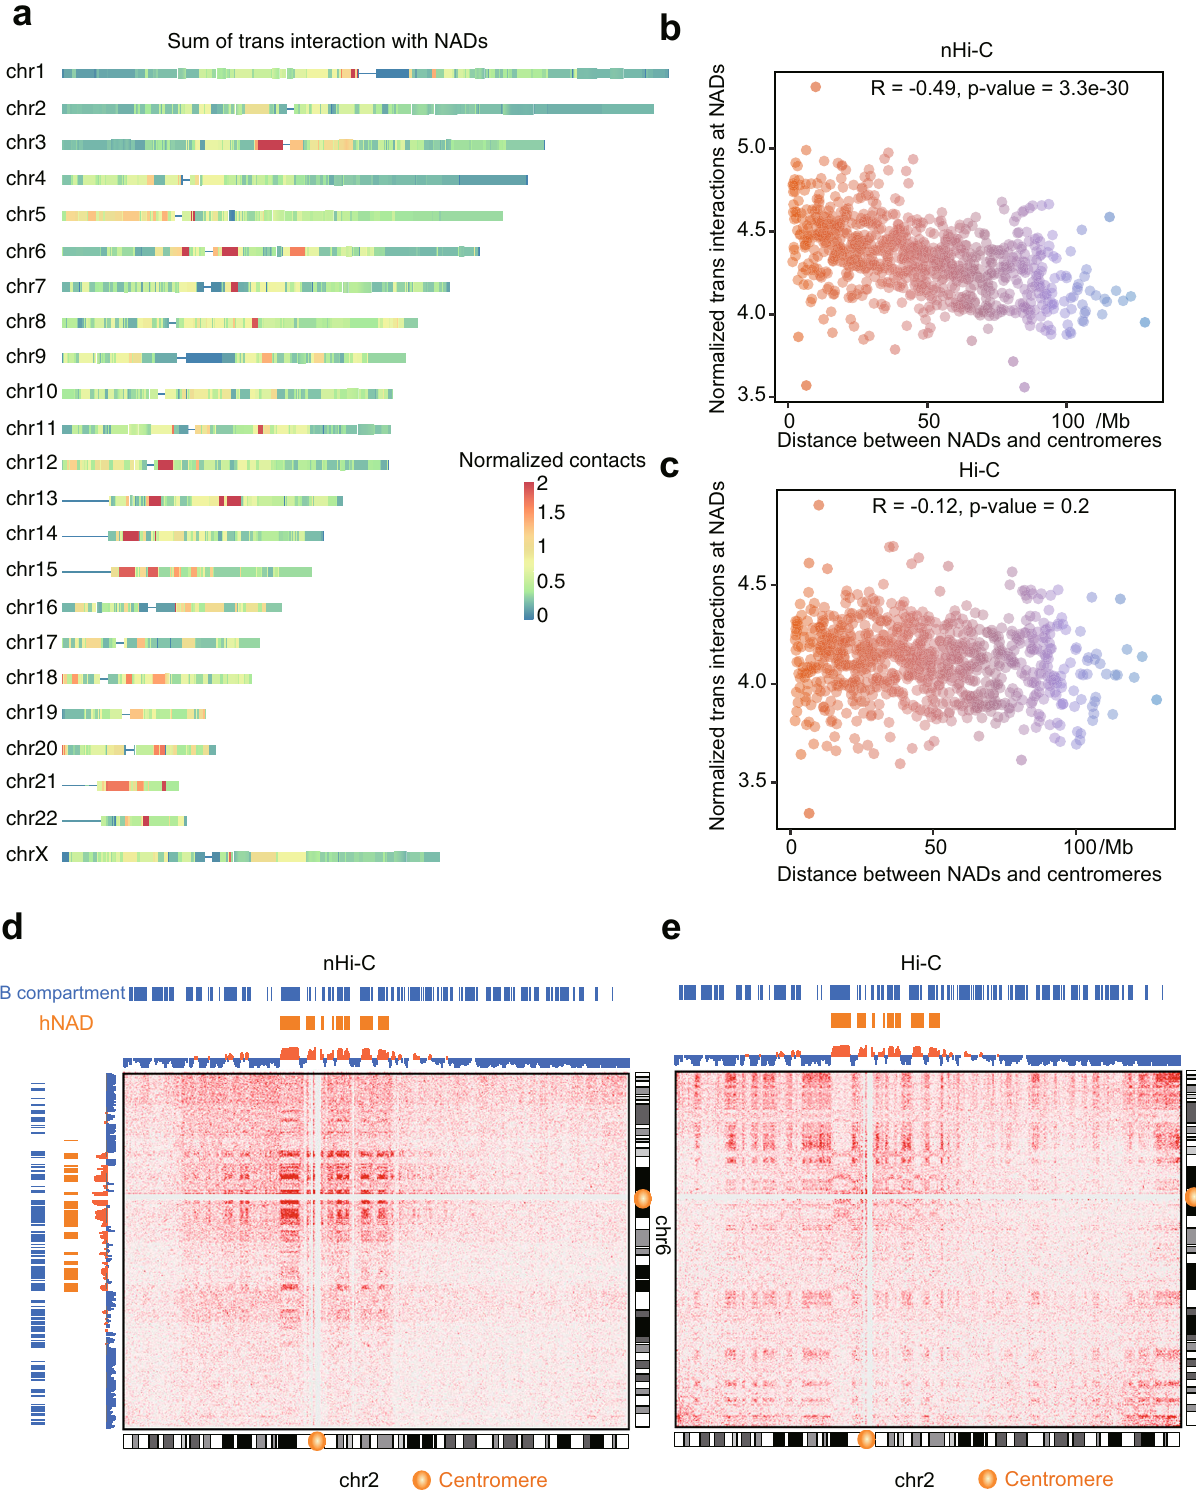
Fig. 5 | Global distribution pattern of nucleolus-associated trans interactions. a Sum of trans interactions with NAD regions for chromosomal bins. b , c Scatter plot of the number of trans interactions associated with NADs ( y axis) and cen- tromere distance ( x axis) from nHi-C ( b ) and in situ Hi-C ( c ) data. Each point